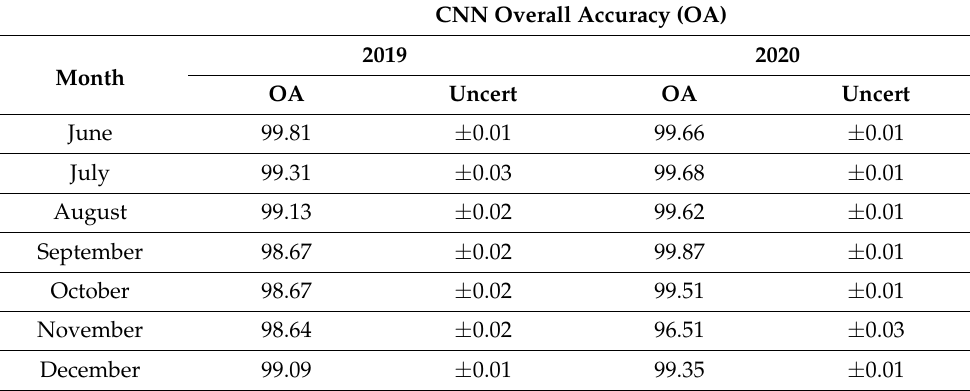
Figure 9. Flood mapping by CNN model: ( A ) Flooded areas in 2019; and ( B ) Flooded areas in 2020 by month in the wet season, from June to December. Table 5. OA and uncertainty of CNN, MLP and RF classifiers by month for the wet